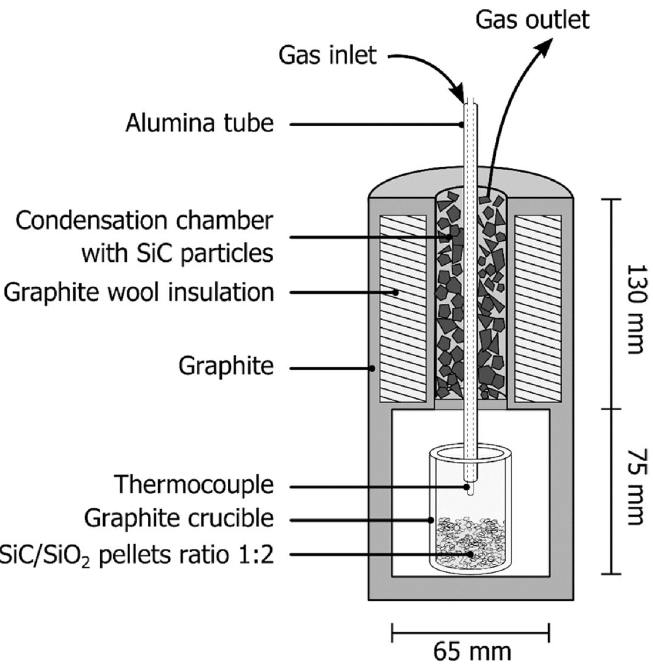
Figure 2. A schematic drawing of the setup used to investigate the reaction between SiO and CH 4 in a CH 4 /H 2